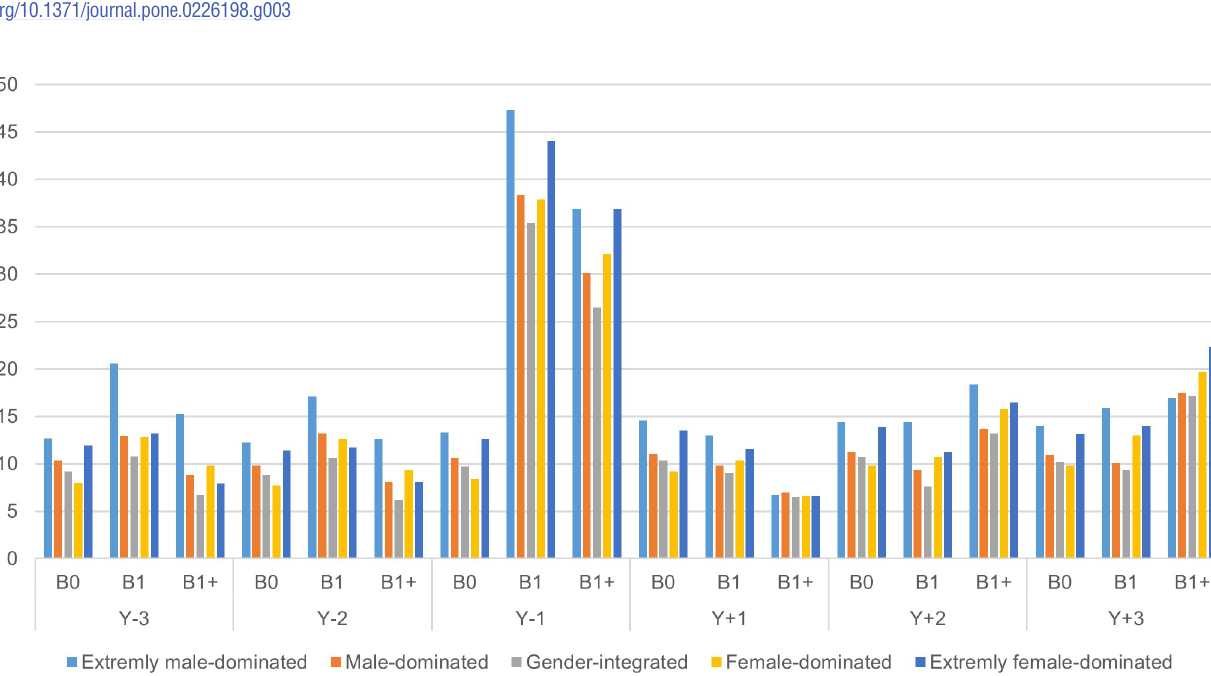
PLOS ONE | https://doi.org/10.1371/journal.pone.0226198 December13,